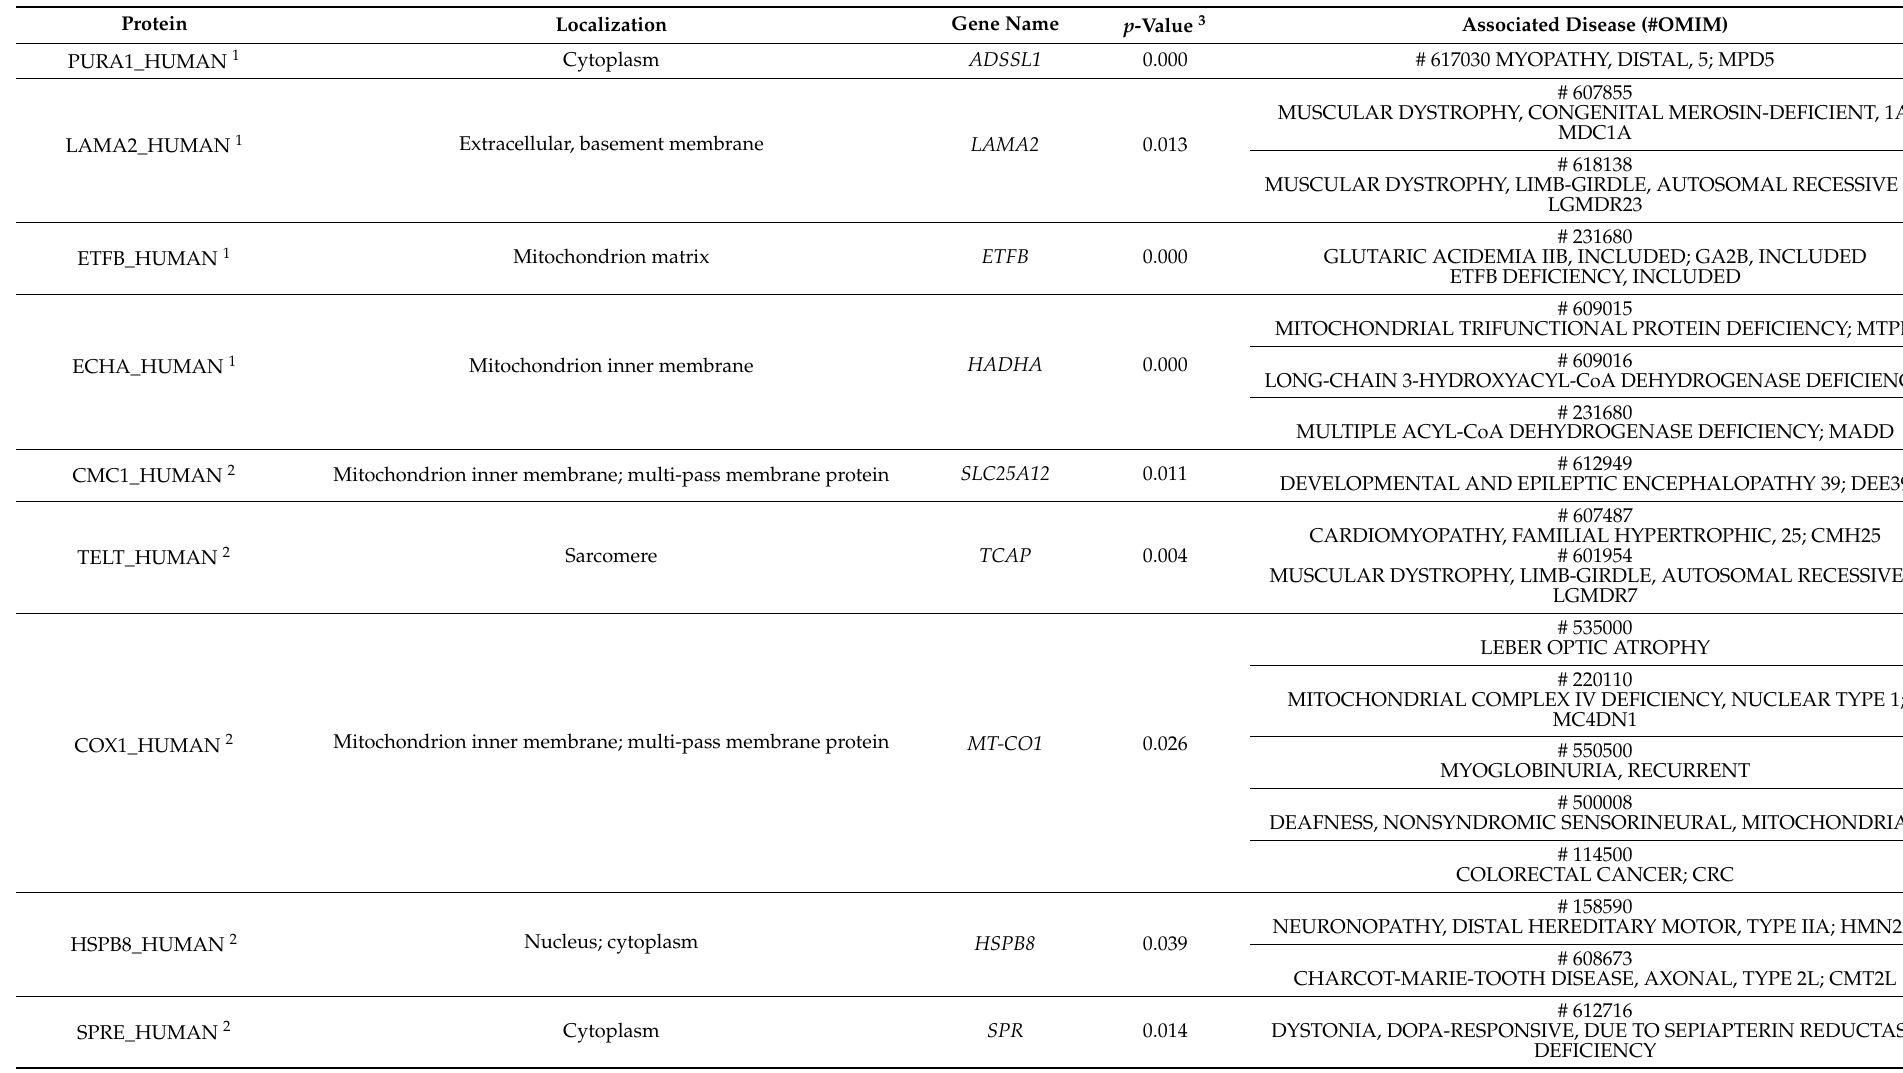
Table 2. Dysregulated proteins and their associated diseases presenting with phenotypical overlap to